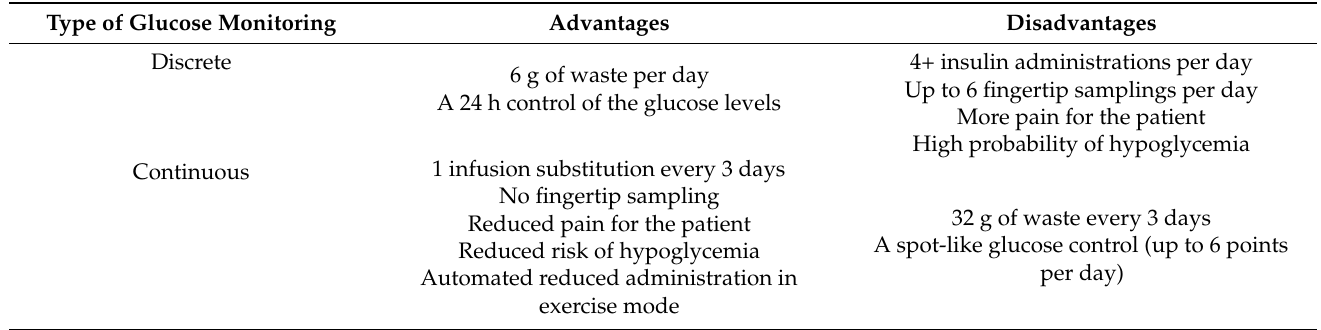
Table 2. Advantages and disadvantages of continuous vs. discrete glucose monitoring systems.